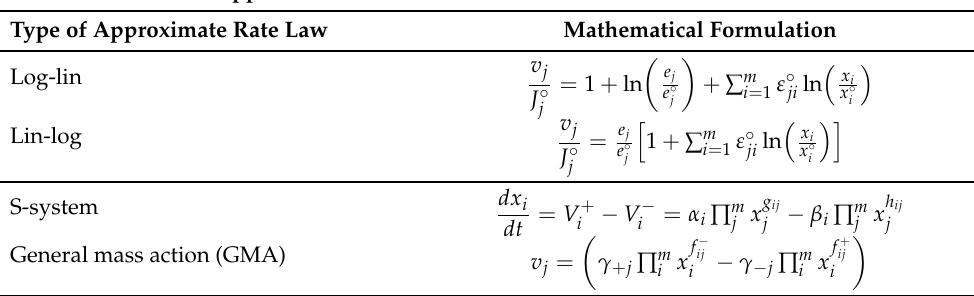
Table 3. Various approximate kinetic formats based on MCA and Biochemical System Theory (BST) using reference parameters and reference elasticities (See the following paragraph for the notation